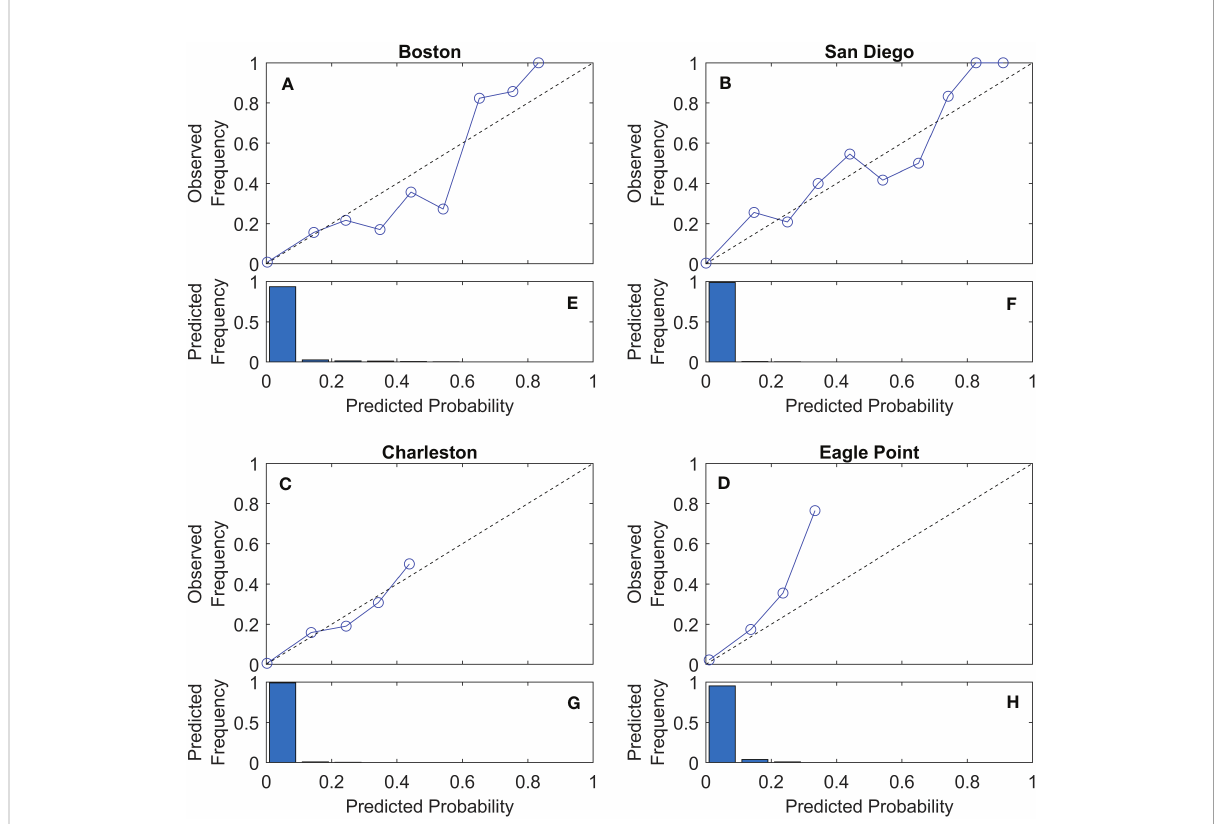
FIGURE 5 Reliability diagrams for Boston, MA, Charleston, SC, San Diego, CA, and Eagle Point, TX for retrospective daily HTF predictions from 1997 – 2019. Plots (A – D) show reliability relative to each predicted probability bin, where the x-axis location of each point is equal to the average of a particular probability bin. Plots (E – H) show the fraction of days predicted in each bin. Note that when no points are shown in a reliability diagram for a particular bin, this indicates 0 predicted probabilities in that bin, while all bins greater than 0.3 generally have too few observations to be visible in the bar